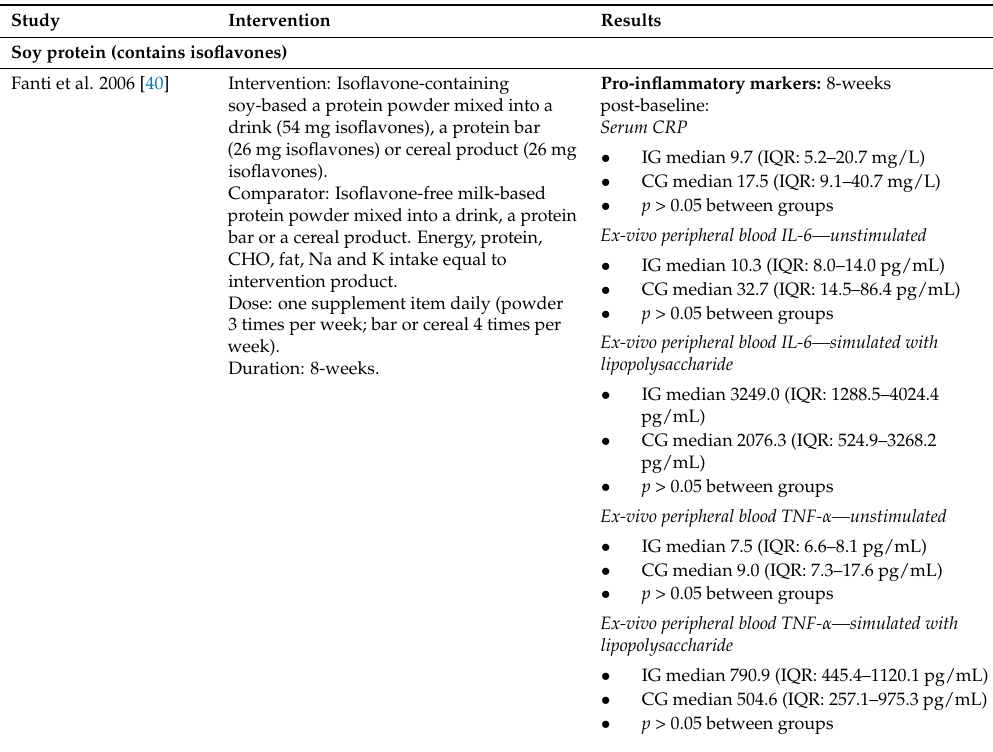
Table 2. Included Study Intervention Details and